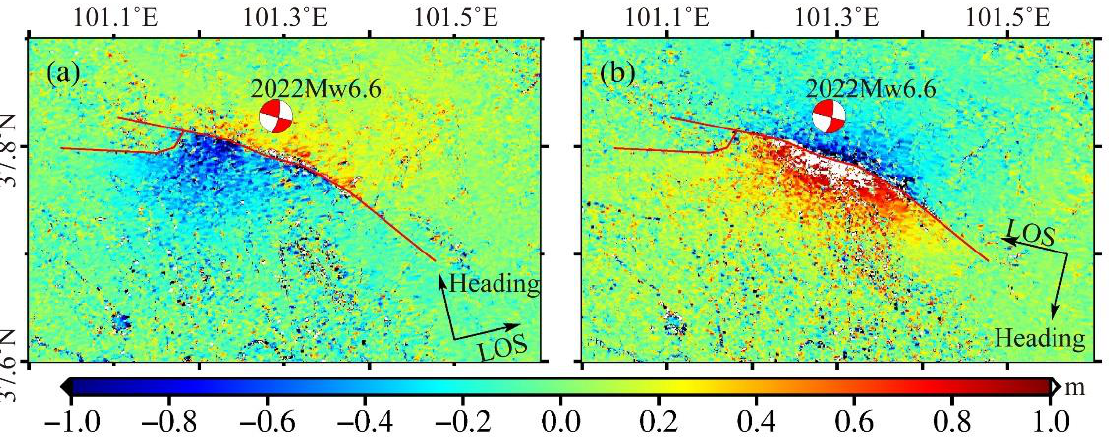
Figure 5. Surface rupture trace of the 2022 earthquake mapped based on the range offset measure- ments. ( a , b ) are the range offset results on the ascending and descending tracks, respectively. The red lines are the two-fault model of the 2022 earthquake.